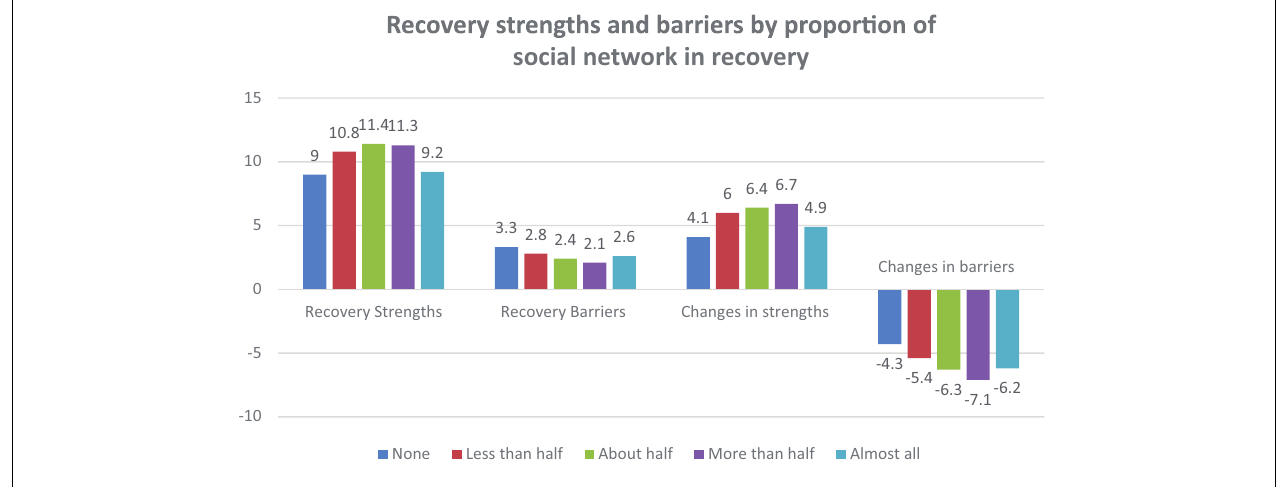
FIGURE 3 | Recovery strengths and barriers by proportion of social network in